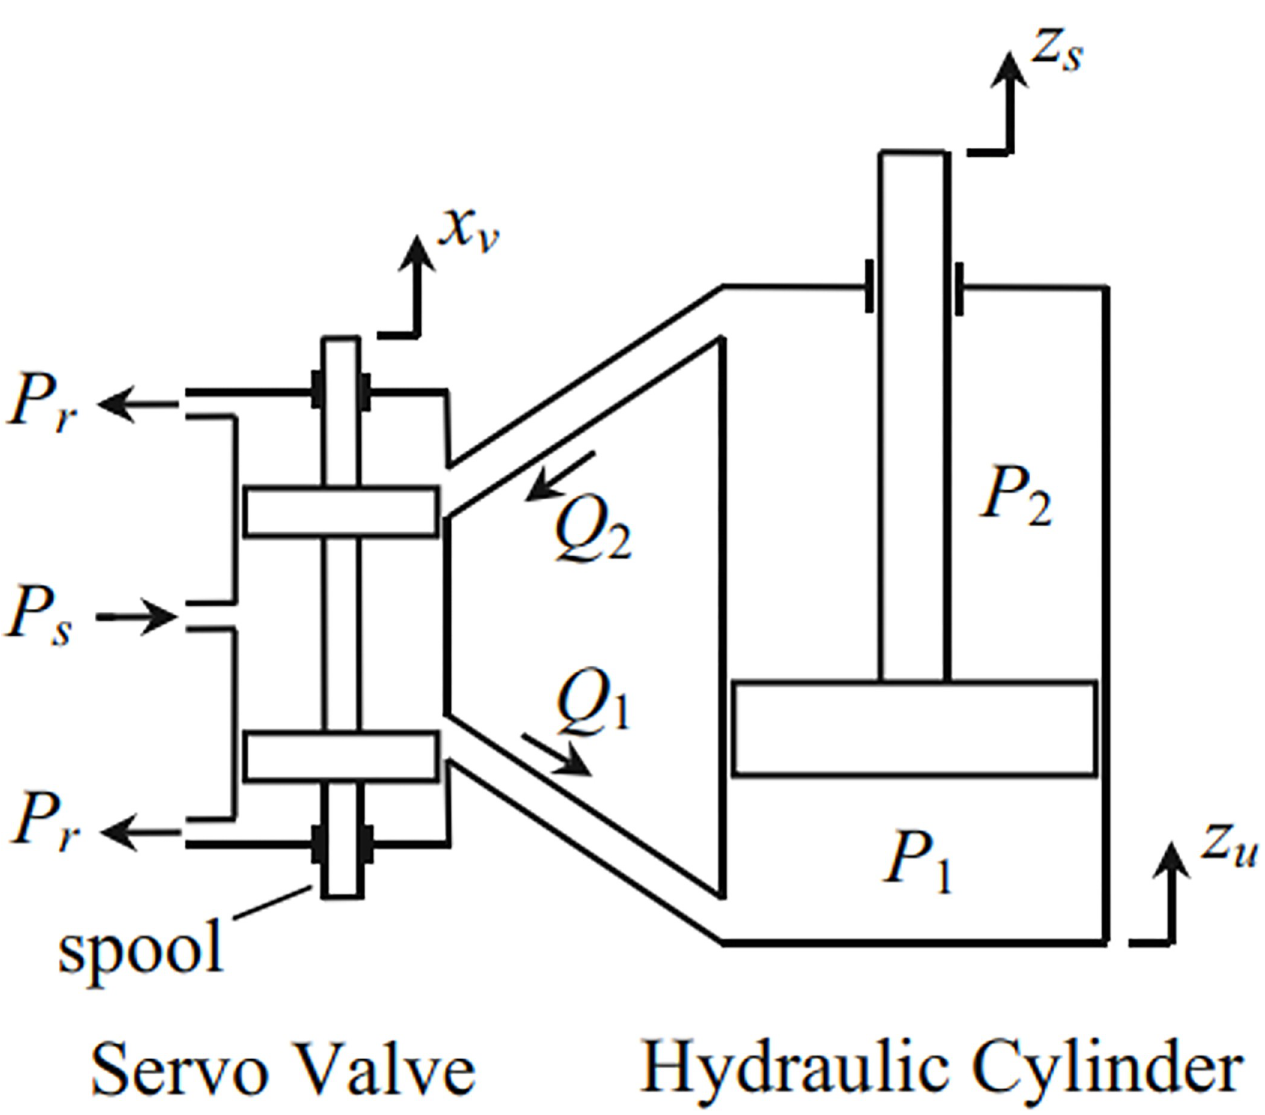
Fig 2. Hydraulic